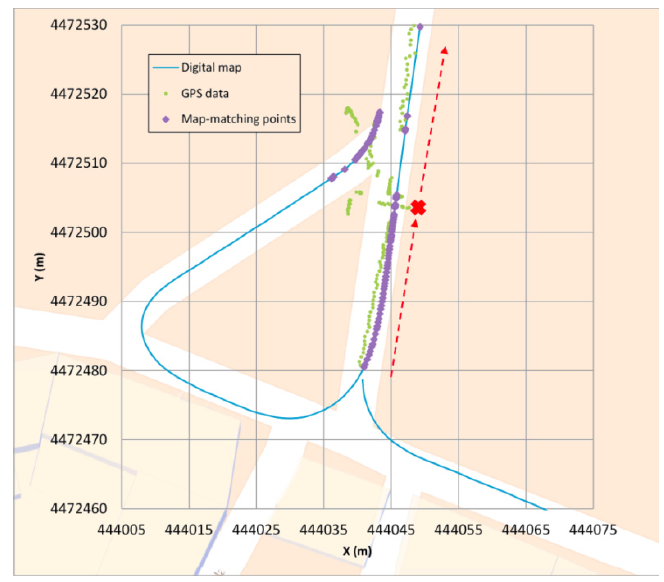
Figure 8. Type III error example.